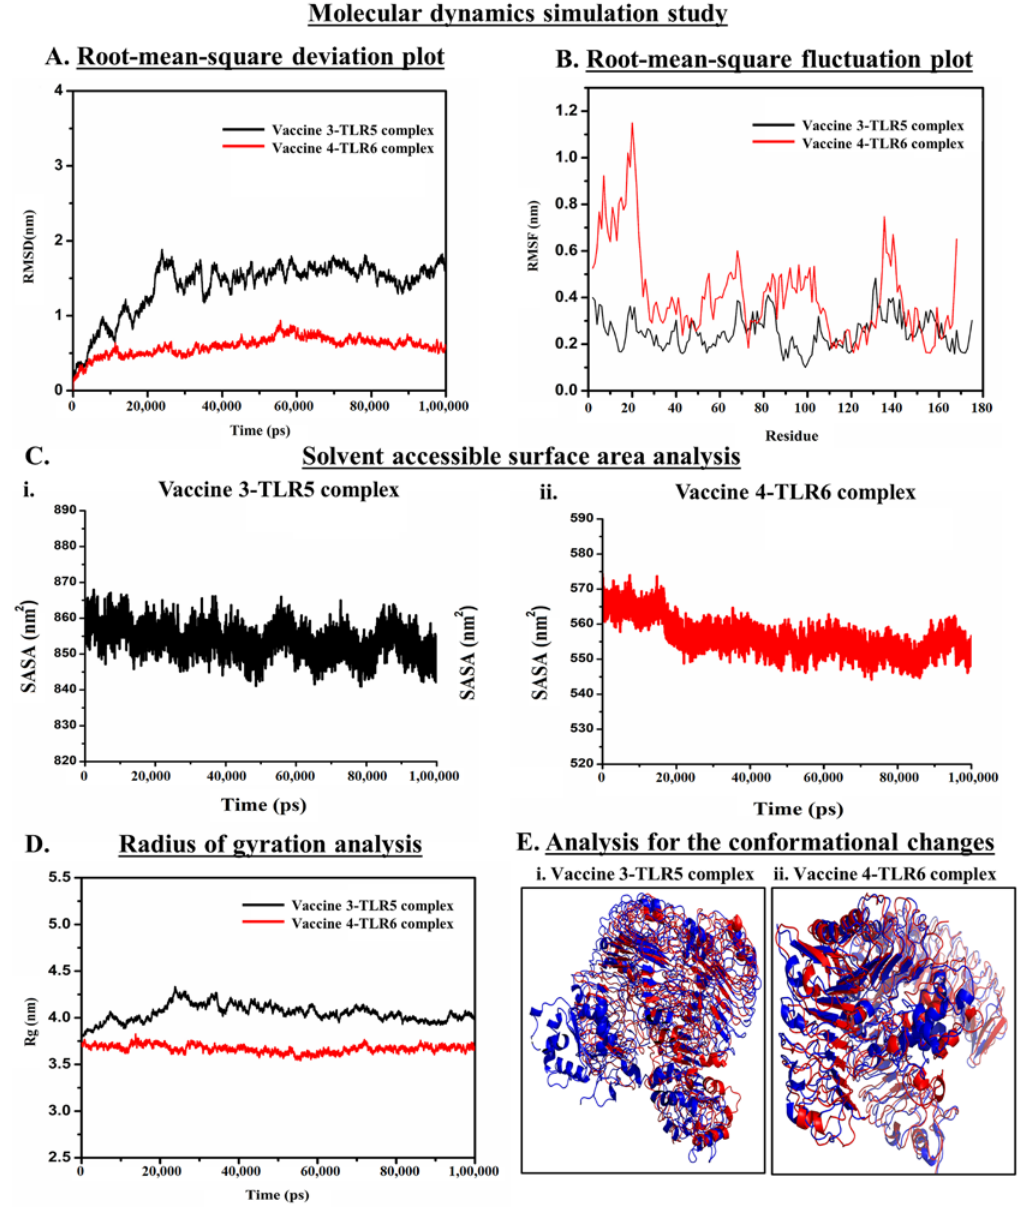
Figure 5. MDS trajectory analysis showing the biophysical stability of VACCINE 3–TLR5 and VACCINE 4–TLR6 complexes. ( A ). RMSD plot generated across the simulation period shows the deviation in the stability of the vaccine–TLR complexes. ( B ). RMSF plots generated by combining the residual fluctuation within the two vaccine–TLR complexes during the entire simulation phase. In the RMSD and RMSF plots, VACCINE 3–TLR5 and VACCINE 4–TLR6 complexes are shown in black and red color, respectively. ( C ). Graphical demonstration of SASA for ( i ). VACCINE 3–TLR5 and ( ii ). VACCINE 4–TLR6 complexes ( D ). Rg plots showing the movement of the interacting proteins within the vaccine–TLR complexes. Black and red lines represent the VACCINE 3–TLR5 and VACCINE 4–TLR6 complexes, respectively. ( E ). Analysis of the conformational changes by the superimposing structure of ( i ). VACCINE 3–TLR5 unbounded state in red color and binding after 100 ns in blue color, and ( ii ). VACCINE 4–TLR6 unbounded state in red color and binding after 100 ns in blue